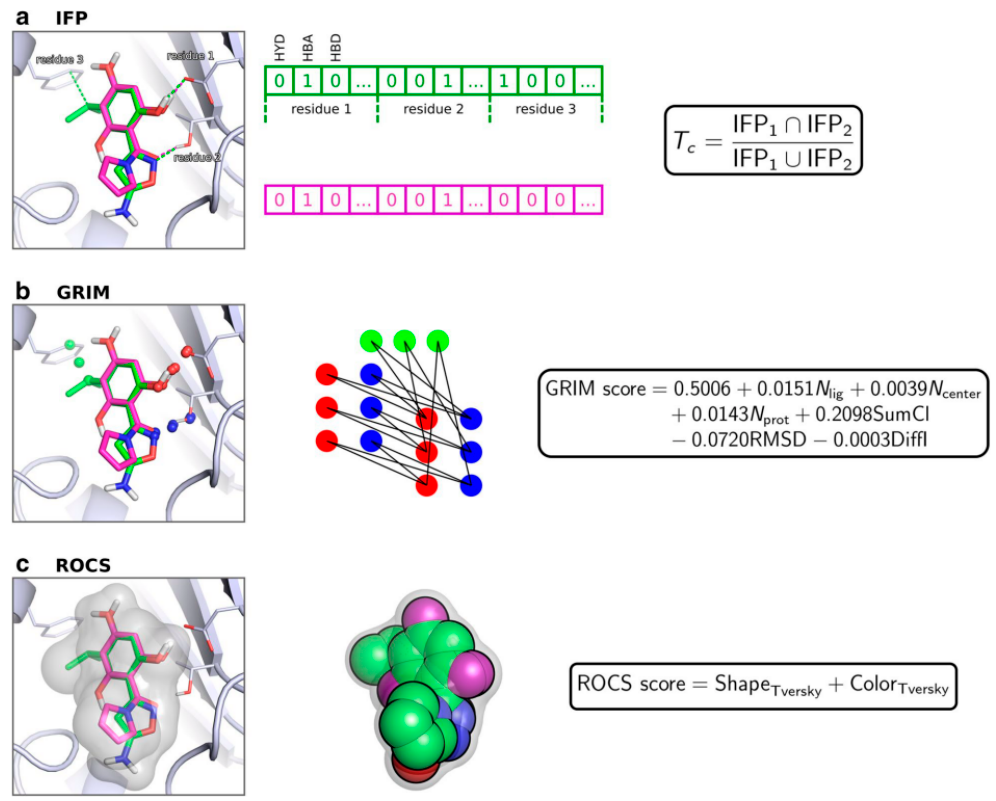
Figure 5. Overview of rescoring methods coupled to interaction fingerprints (IFP), graph matching (GRIM), and ROCS. ( a ) In the IFP score Tc denotes the Tanimoto coefficient. ( b ) In the GRIM score, N lig is the number of aligned ligand points, N center stands for the number of aligned centered points, N prot is the number of aligned protein points, SumCl is the sum of clique weights over all weights, RMSD is the root mean square deviation of the matched cliques, and DiffI stands for the difference between the number of interaction points in the query and the template compound. ( c ) The ROCS score is based on the Tversky coefficient. Reprinted with permission from Springer Nature [79].